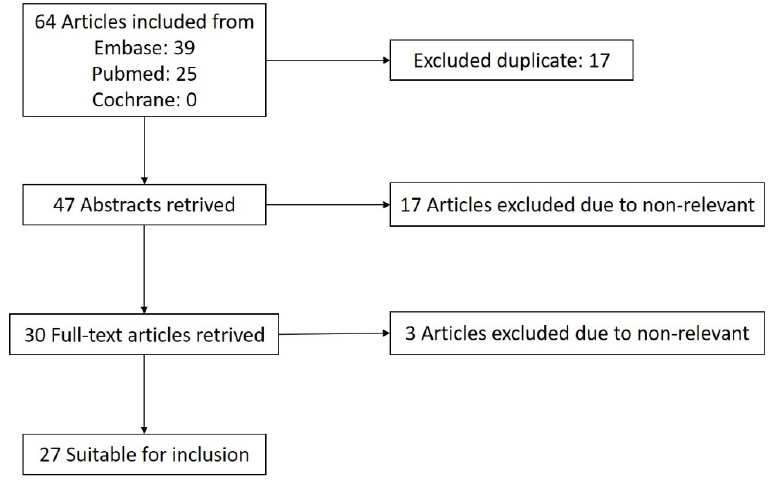
Figure 1. Flow chart of article selection. Table 1. Review of literatures about corneal complications after COVID-19 vaccination.